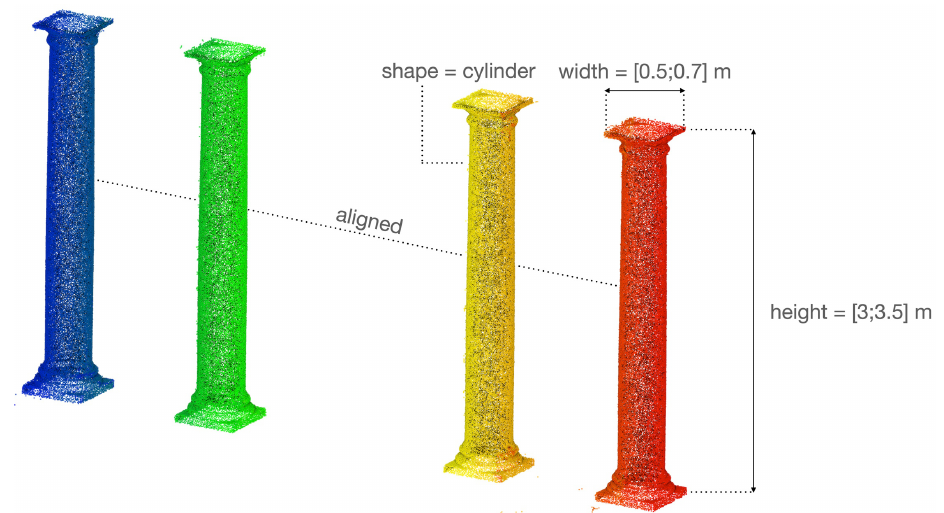
Figure 8. Knowledge about the object